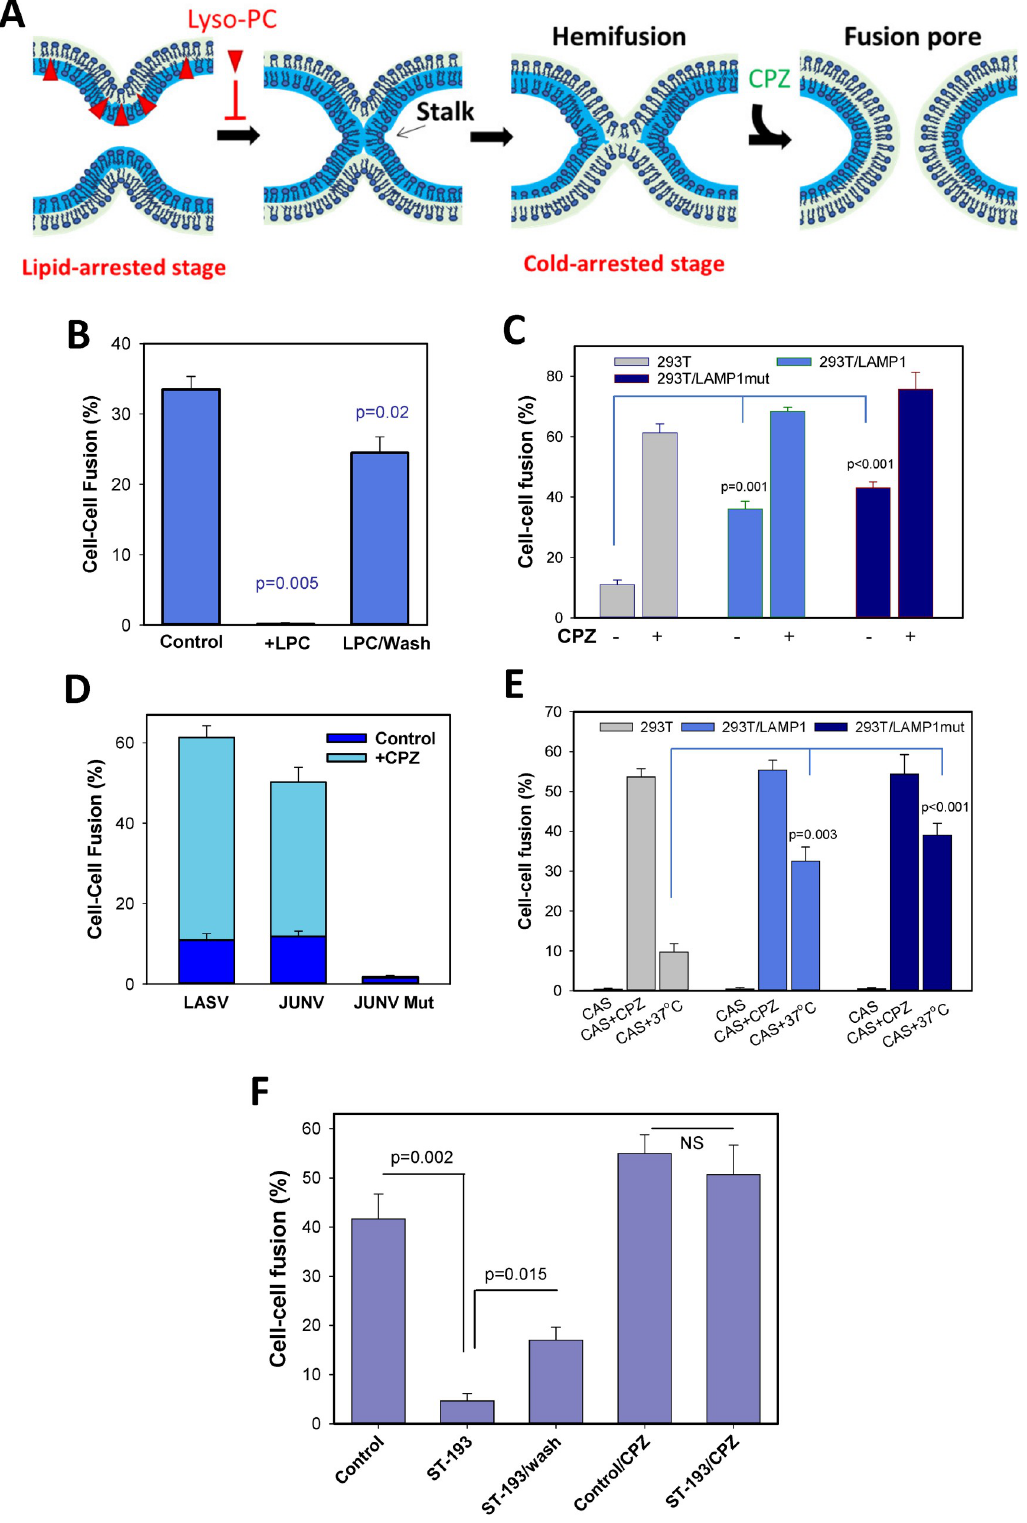
Fig 4. LASV GPC-mediated fusion progresses through a hemifusion intermediate that is blocked by lyso-lipids. (A) Illustration of cold-arrested (CAS, hemifusion) and lyso-lipid-arrested (LAS, pre-hemifusion) intermediates and the effect